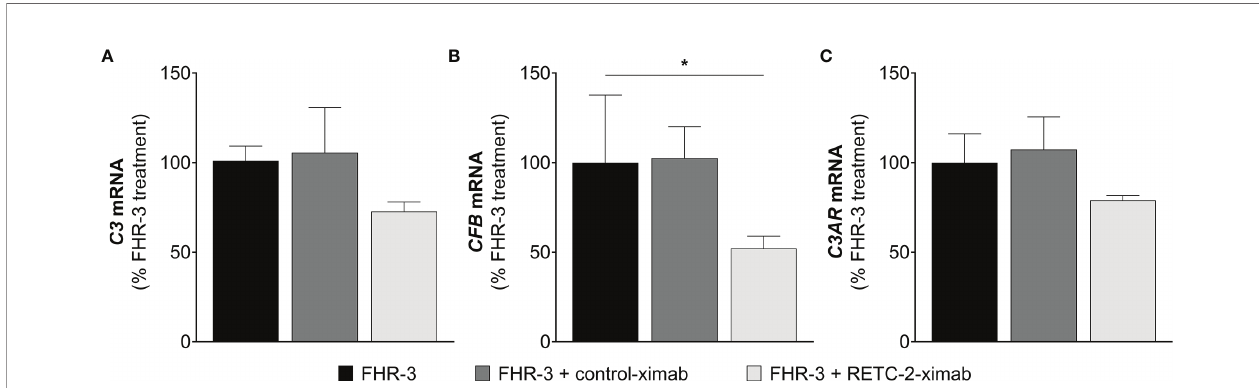
FIGURE 9 | RETC-2-ximab slightly ameliorated the effect of FHR-3 on ARPE-19 cells. ARPE-19 cells were treated with either FHR-3 (black), FHR-3 and control- ximab (anti-BSA, dark grey) or FHR-3 and RETC-2-ximab (anti-FHR-3, light grey). (A) C3 mRNA expression was reduced by 27%, (B) CFB mRNA expression was reduced by 48%, and (C) C3AR mRNA expression was reduced by 21% when incubated with FHR-3 and RETC-2-ximab compared to FHR-3 alone. Shown is the relative mRNA expression to FHR-3 treated cells in %. Mean with standard deviation is shown. *p < 0.05. Unpaired t-test (n =